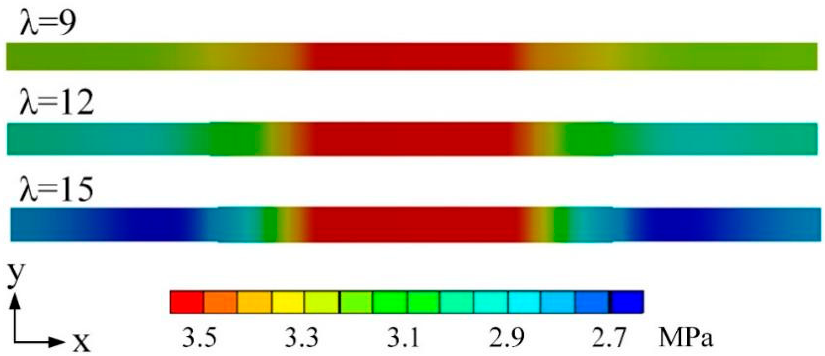
Figure 9. Comparison of the polarization curves for the Base case*, Case 1* and Case 2*. Figure 10 shows the deformation and equivalent stress distribution of the membrane with λ of 9, 12 and 15, corresponding to Case 4*, Case 3* and Case 2* shown in Table 2, respectively. The results show that the deformation of the membrane increases with the water content. The membrane under the channel produces significantly larger swelling than that under the rib due to the constraint of the bipolar plate. Correspondingly, the equivalent stress distribution of the membrane with λ of 9, 12, and 15 is also given in Figure 10. The membrane below the flow channel undergoes an increasing amount of swelling and deformation as the water content increases, and therefore, the stress is signifi- cantly greater than those of the membrane under the rib. The stress under the rib decreases with increasing water content, possibly due to higher stress withstood by the membrane under than channel.